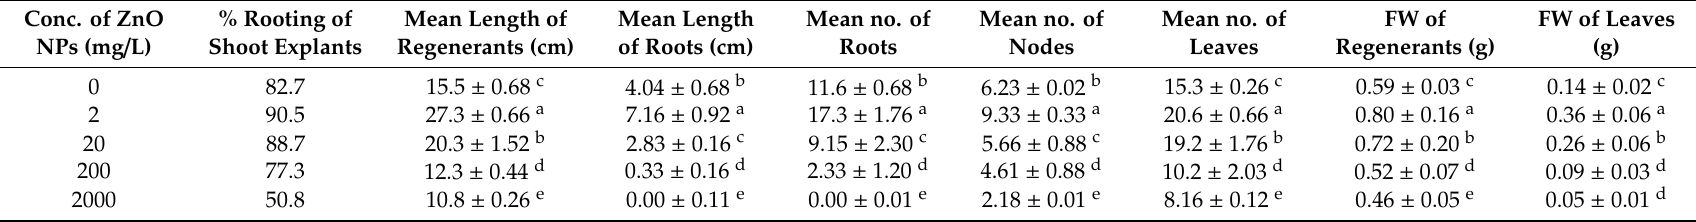
Table 2. Comparison of morphological parameters in 8 weeks old regenerants produced from shoots on the Murashige and Skoog (MS) medium supplemented with di ff erent concentrations of ZnO ENPs. Conc. of ZnO % Rooting of Mean Length of NPs (mg / L) Shoot Explants Regenerants (cm)